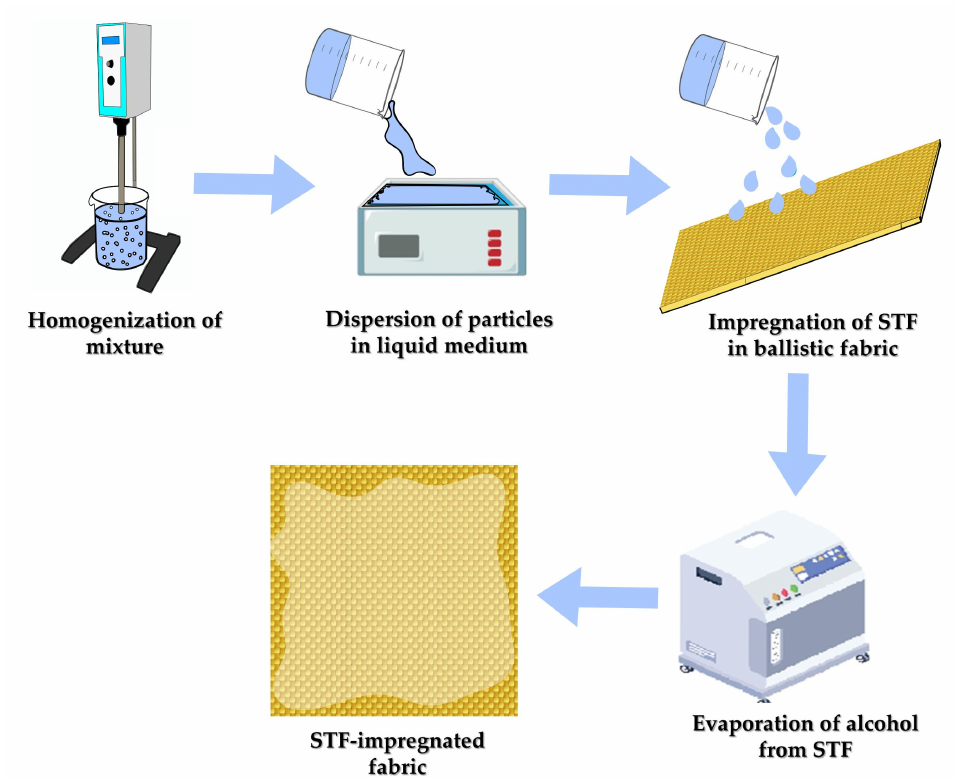
Figure 3. Scheme of preparation method of shear thickening